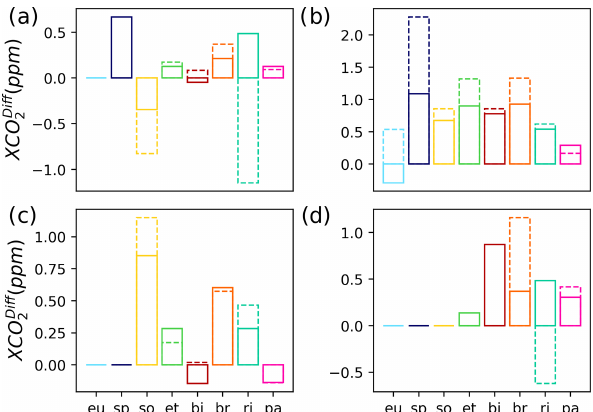
Figure 5. The bias at each site for the different seasons when the NN filter (bars with solid lines) and qc_flag (bars with dashed lines) are used to filter the OCO-2 retrievals in the validation data set. (a) Spring (March, April, May); (b) summer (June, July, August); (c) fall (September, October, November); (d) winter (December, January, February). Note the different y -axis ranges for each plot. Note that bars that show a bias of zero are due to no data rather than a bias of